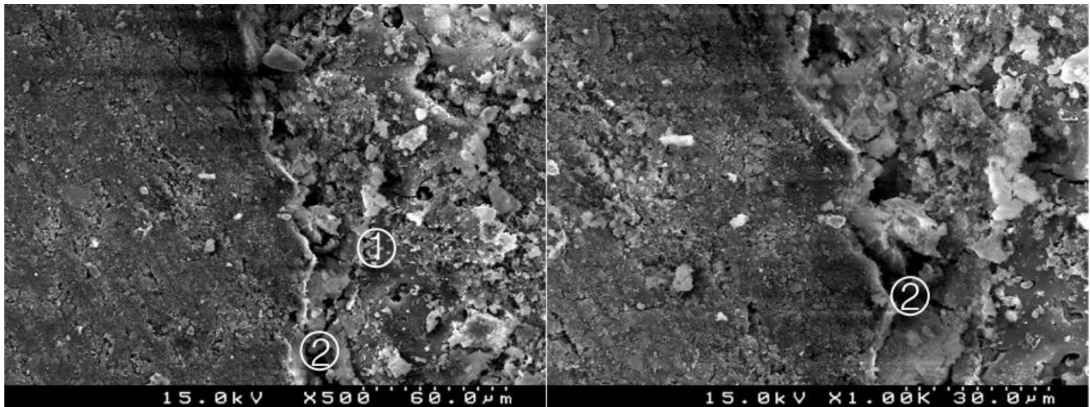
Figure 3. Group 1 (BiodentineSE0I): straight interdiffusion of the adhesive material protruding into the CSC. Cement particles are involved by the adhesive; a CSC/adhesive hybrid layer is observed 1 (cid:13) with some empty spaces on the top of the hybrid layer 2 (cid:13) (original 500 × and 1000 ×